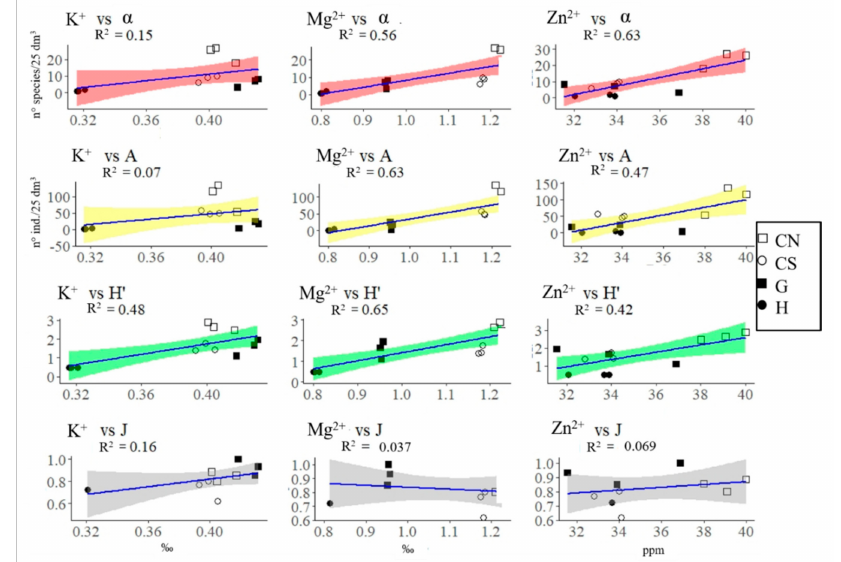
Figure 5. Linear regression models between environmental parameters (independent variables) and synecological indices (dependent variable) of Polychaeta assemblages. In red—relations among environmental variables and α -diversity ( α ); in yellow—relations among environmental variables and abundances (A); in green—relations among environmental variables and diversity index (H’); in grey—relations among environmental variables and evenness (J). Significant R 2 is also shown for each